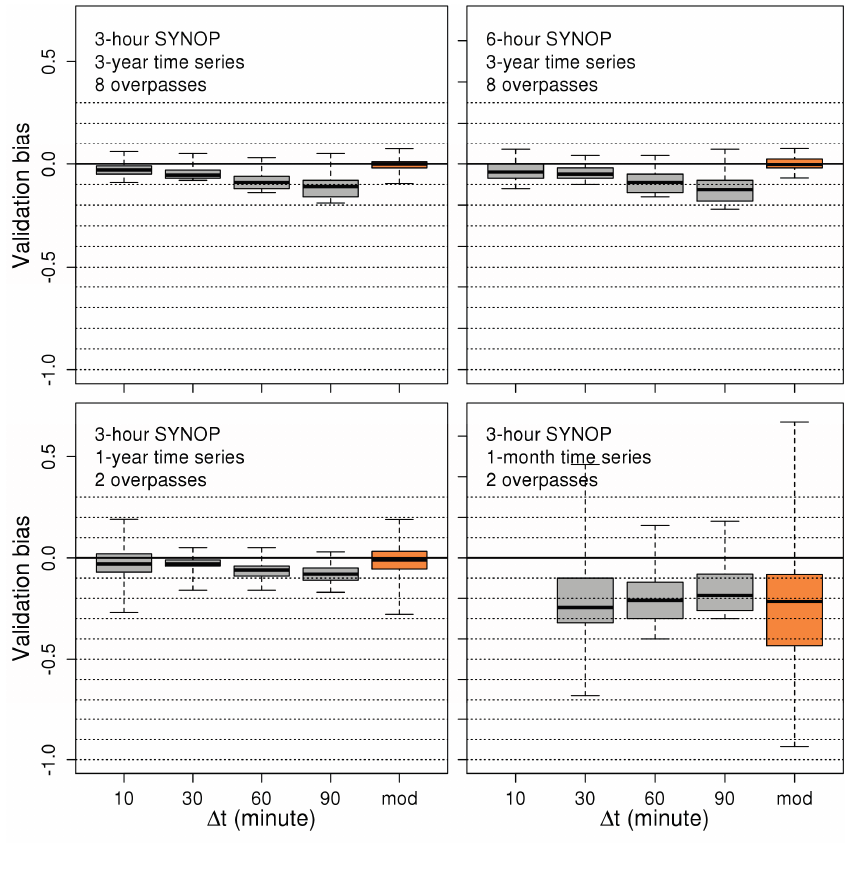
Figure 8. The bias in Hanssen-Kuiper’s discriminant measured against the unbiased skill score (HK 0 ) at Payerne depending on the SYNOP observation frequency, time series length, and number of satellite overpasses per day. The bias is reported for four different maximum time differences between the satellite observation and SYNOP (HK Δ t= 10m, HK Δ t= 30m, HK Δ t= 60m , and HK Δ t= 90m ), and for the modeled skill score (HK mod , orange). The missing box is due to n < 10 for which HK is not calculated. The boxes contain a median (thick line), their bottom and top identify the 1 st and 3 rd quartiles, and the whiskers extend to the data